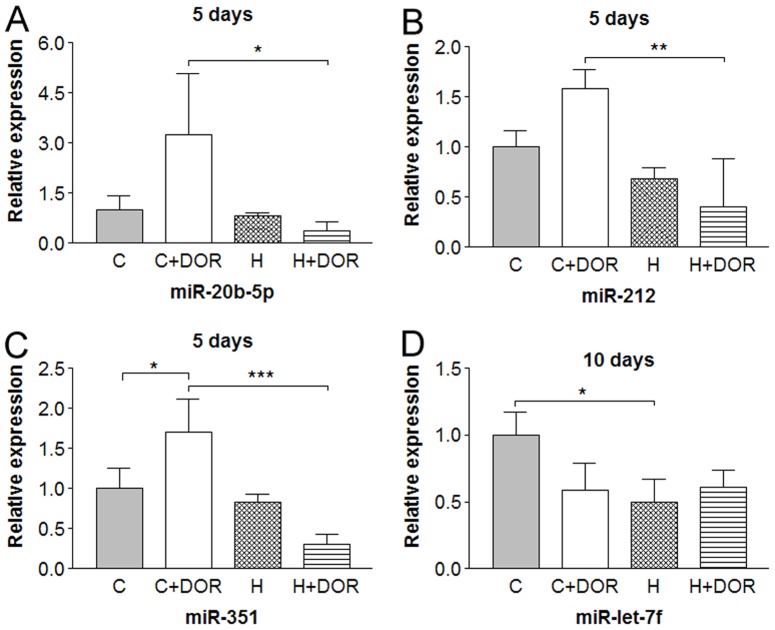
Relative miRNA expression levels of miR-20b-5p, -212, -351 and miR-let-7f in the rat cortex following 5 or 10 days of hypoxia.C: control; C+DOR: control+DOR agonist UFP-512; H: hypoxia; H+DOR: hypoxia+ DOR agonist UFP-512. *p<0.05, **p<0.01, ***p<0.001. Note that the expression of miRs-20b-5p, -212 and -351 was not significantly affected by 5 days of hypoxia alone, but significantly suppressed in the co-presence of hypoxia and UFP-512. The expression of miR-let-7f was significantly reduced by 10-day exposure to hypoxic conditions, but was not affected by UFP-512.